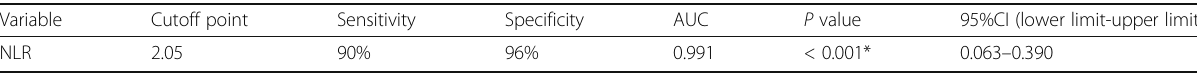
Table 5 Neutrophil/lymphocytic ratio for prediction of Modified Rankin Scale (MRS ≥ 3) after 3 months from stroke